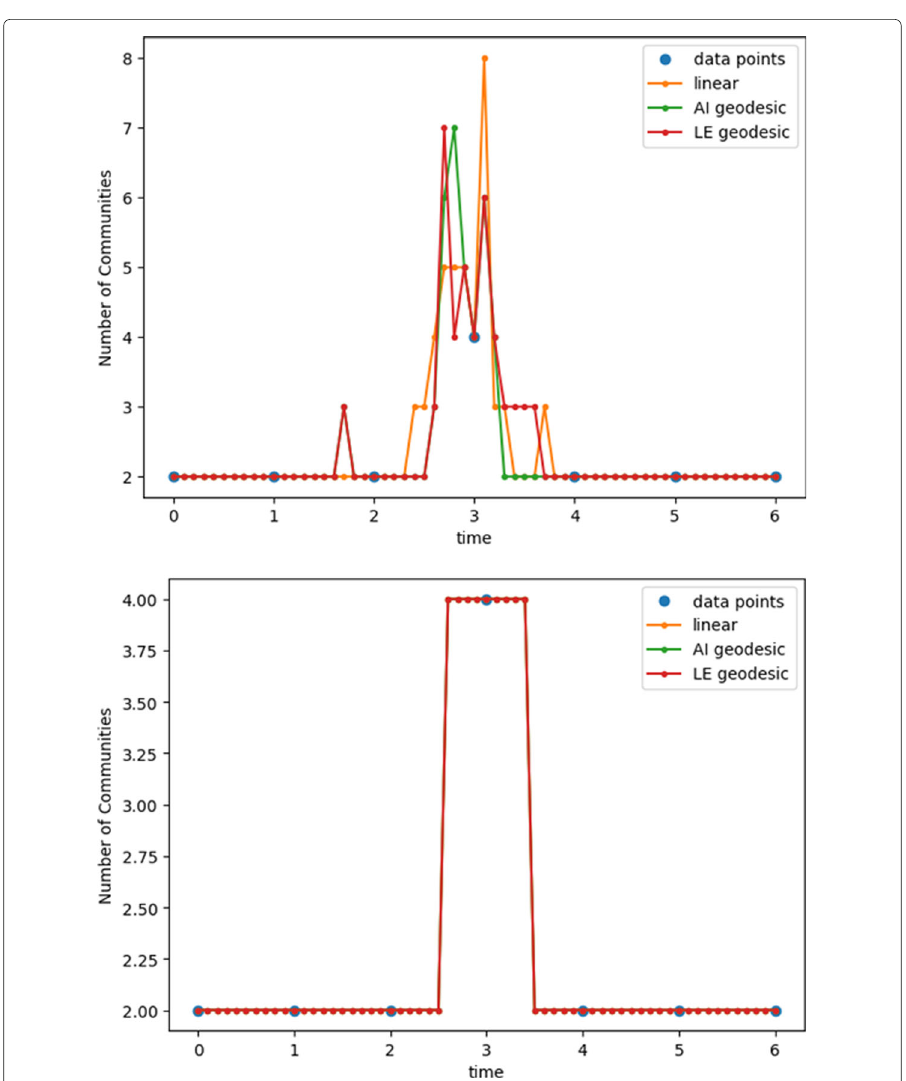
Fig. 6 Communities in interpolated synthetic graphs. When no threshold is applied ( top ), the Louvain method produces varying numbers of communities during the merger of the two original communities, and even the data snapshot of the merged communities shows not one but four communities; we also see some differences between the two geodesic interpolations. With a threshold ( bottom ), though, the piece-wise constant nature of the interpolation shows forth